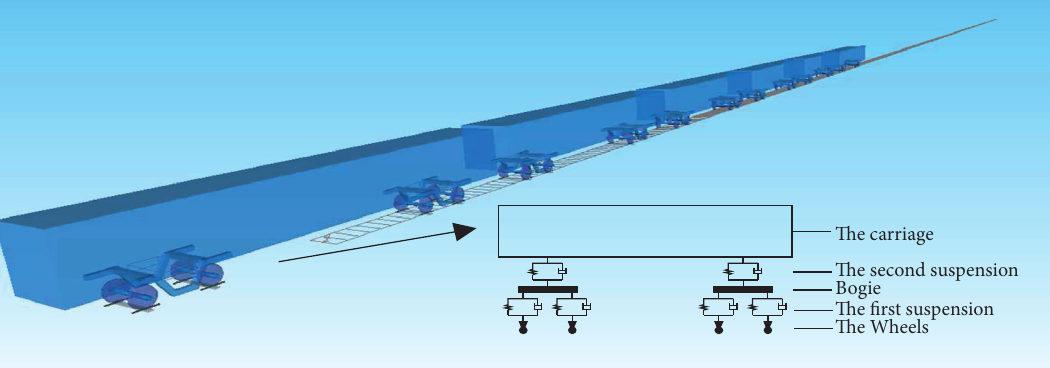
Figure 2: Subway train marshaling. Table 5: Orbital physical